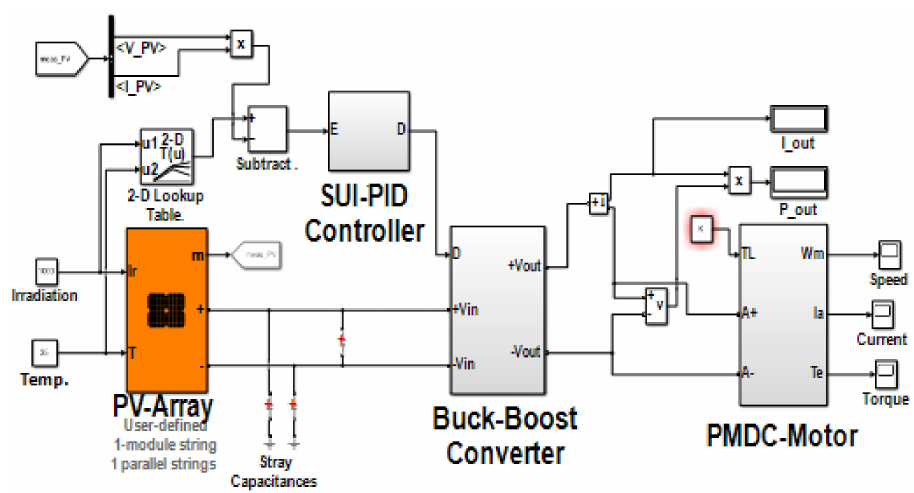
Figure 8. Simulink model of the system with the